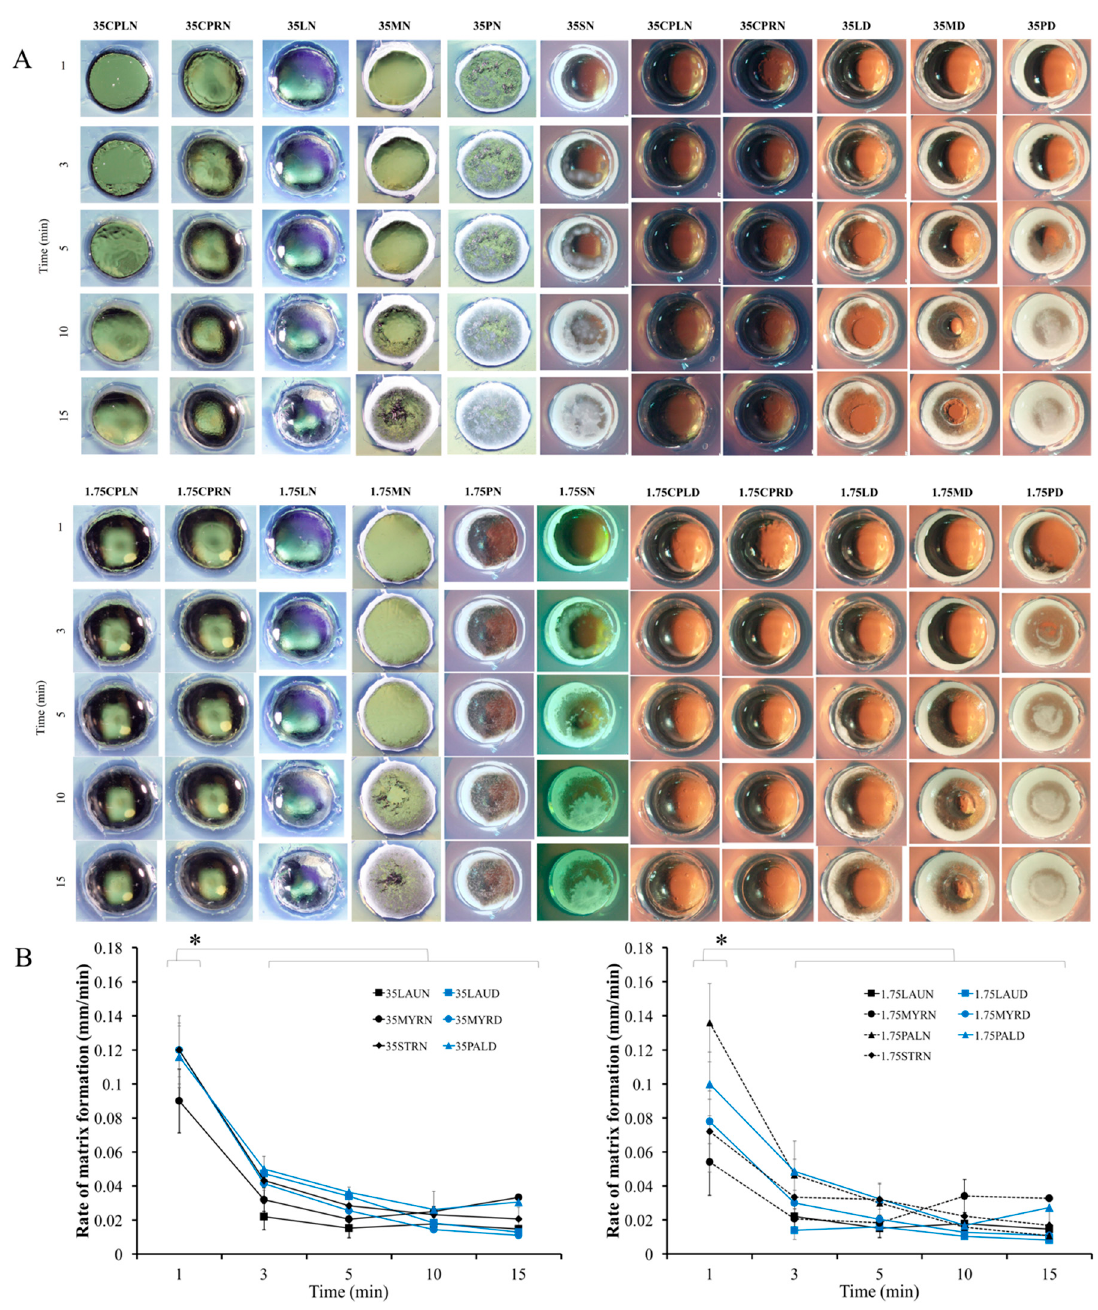
Figure 2. Cross-sectional view of matrix formation ( A ) and its rate over time in the agarose well ( B ) (triplicate testing; n = 3). * represents p <